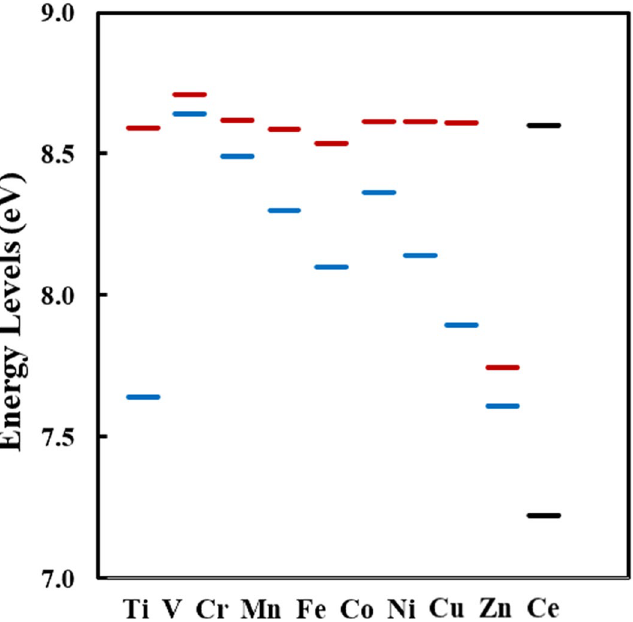
Figure 5. The LUMO (eV), HOMO (eV) level, and the bandgap (eV) in each M@Ce 12 O 8 36+ cluster model is based on the reference level as the vacuum level, as described in Table 3. The HOMO level is colored in blue, and the LUMO level is colored in red. In the undoped pure ceria, the HOMO and LUMO levels are colored in black.